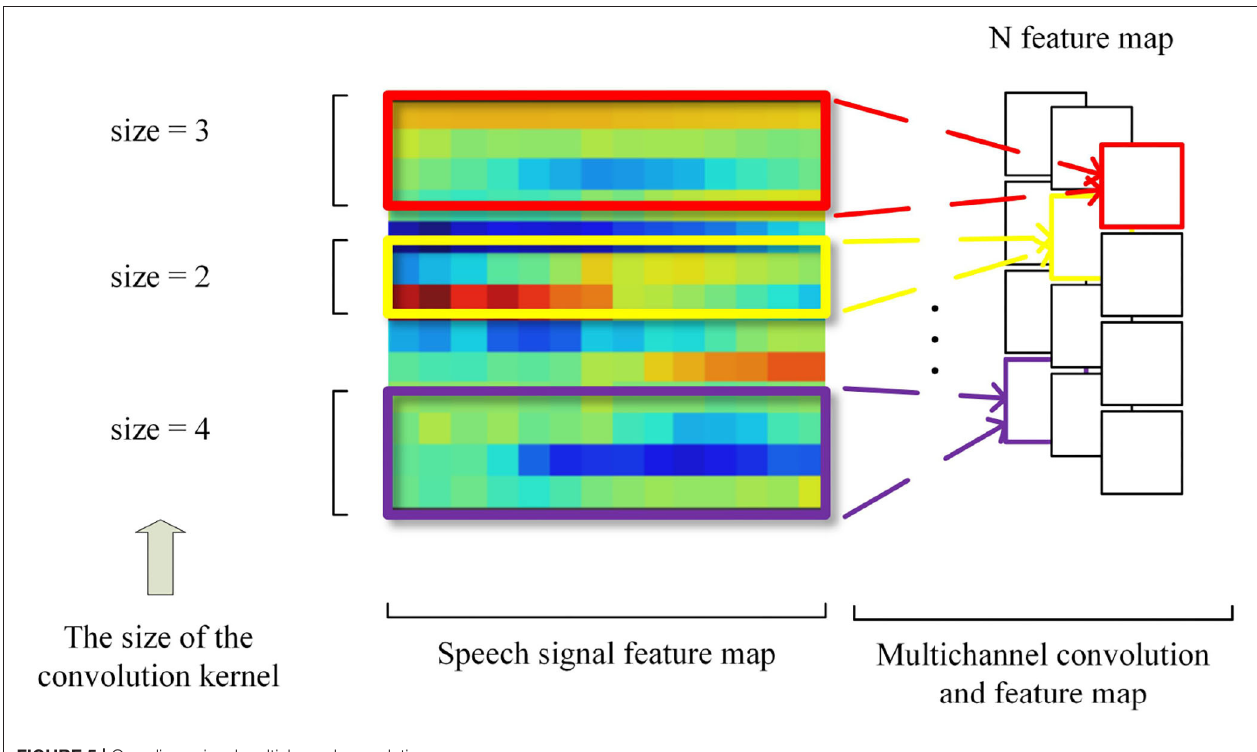
FIGURE 5 | One-dimensional multichannel convolution.